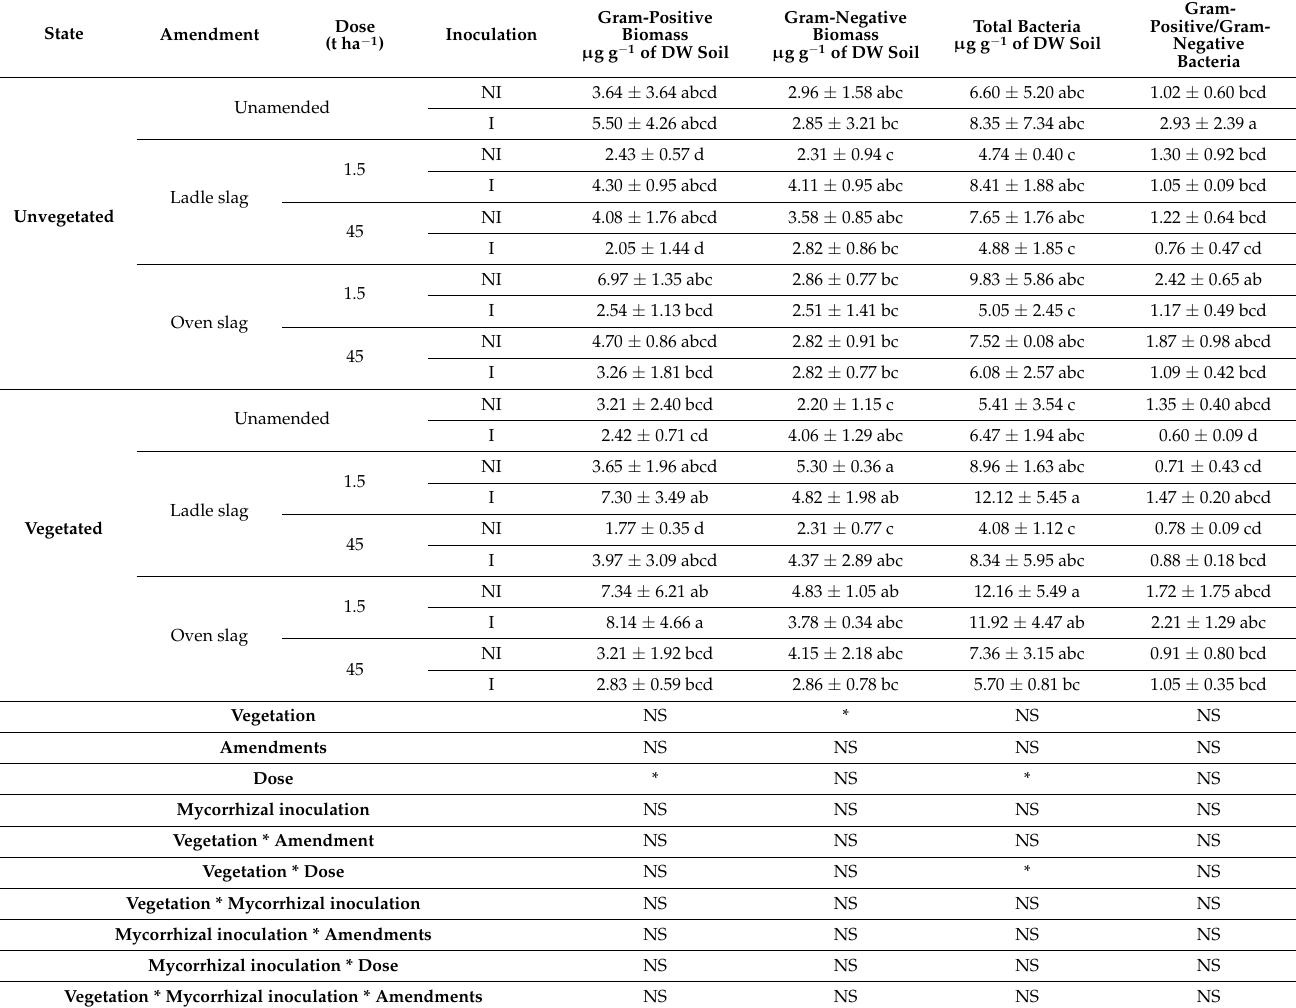
Table 2. Influence of amendments (ladle slag and oven slag used at 1.5 and 45 t ha − 1 ), inoculation and vegetation on Gram-positive, Gram-negative and total bacterial biomass ( µ g g − 1 of dry weight (DW) soil), and Gram-positive/Gram-negative ratio in trace element-polluted soil. Data are presented as means ± standard error. The means were obtained from three replicates ( n = 3). Means followed by the same letter are not significantly different, by one-way ANOVA comparison and post-hoc Fisher test ( α =